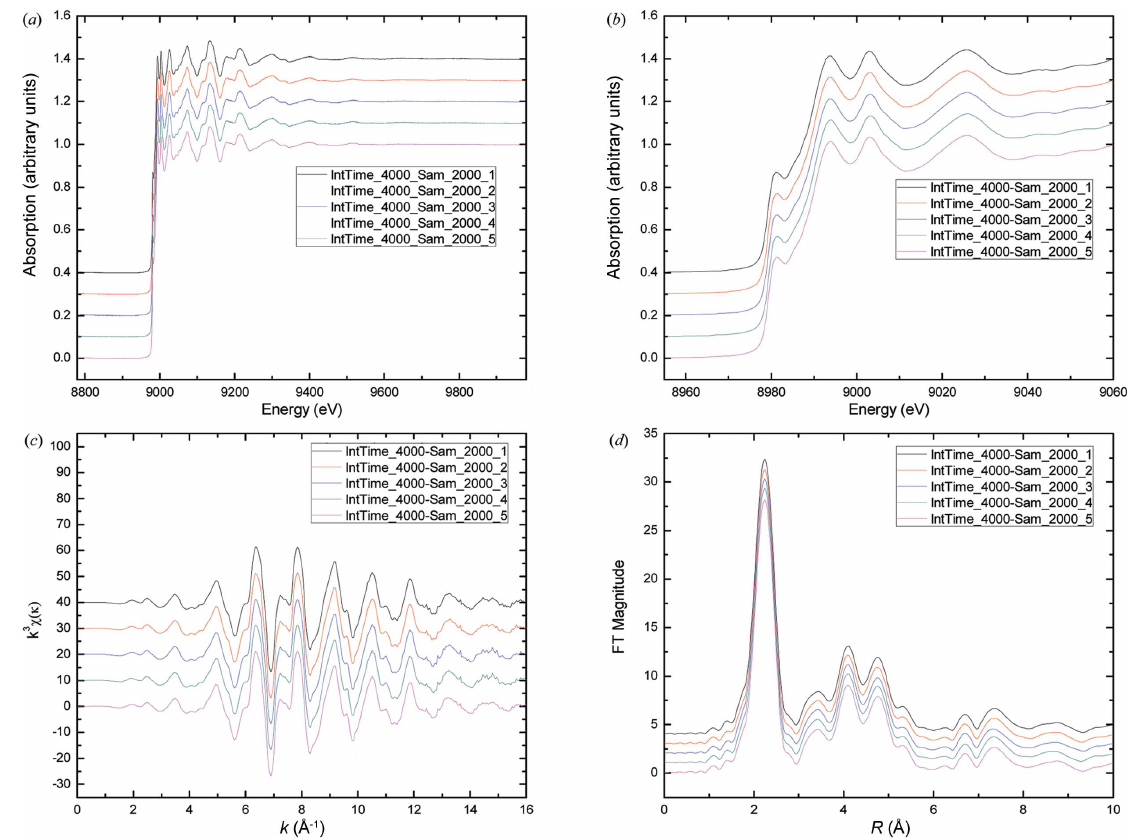
Figure 9 Cu K -edge XAFS spectra with a 1200 eV energy range measured by the QEXAFS system under the same conditions. ( a ) Normalized XAFS spectra, ( b ) near-edge part, ( c ) k -space spectra, ( d ) R -space